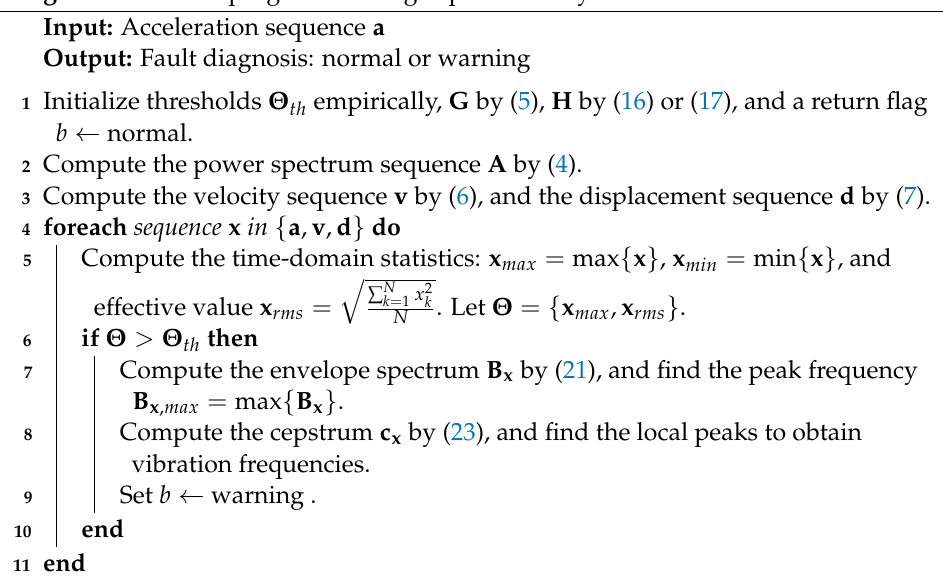
Algorithm 1: Fault prognosis through spectral